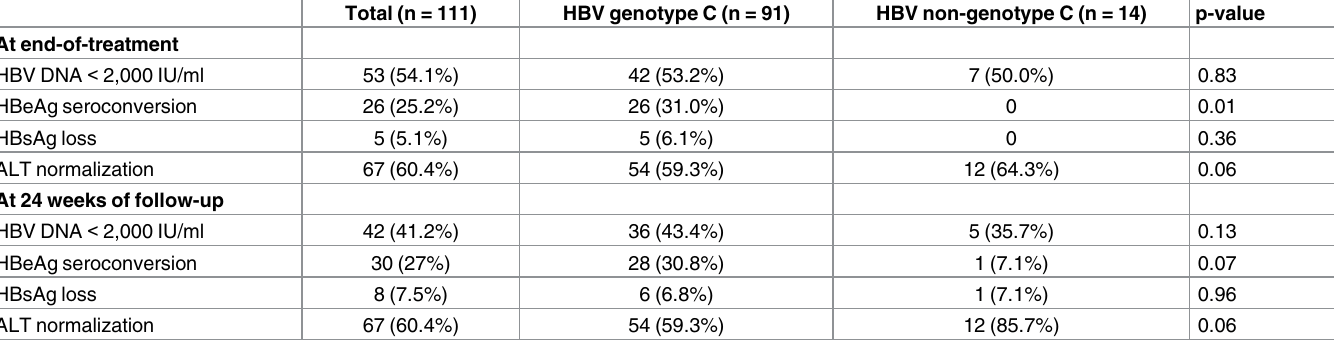
Table 3. Outcomes in patients with HBeAg-positive CHB infection stratified by HBV genotype after completing 24 weeks of PegIFN